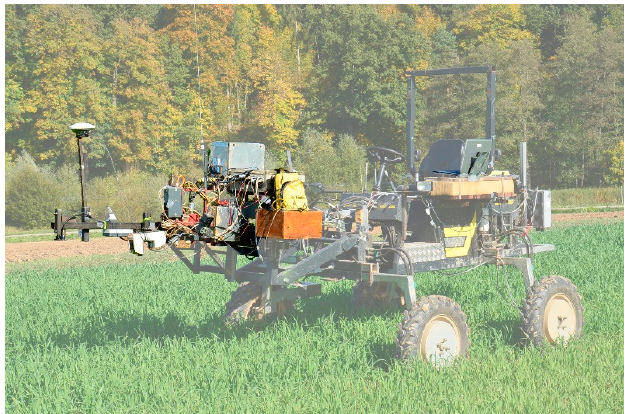
Figure 4. Sensor carrier PhenoTrac IV, customized by the Chair of Plant Nutrition from the Technical University of Munich.